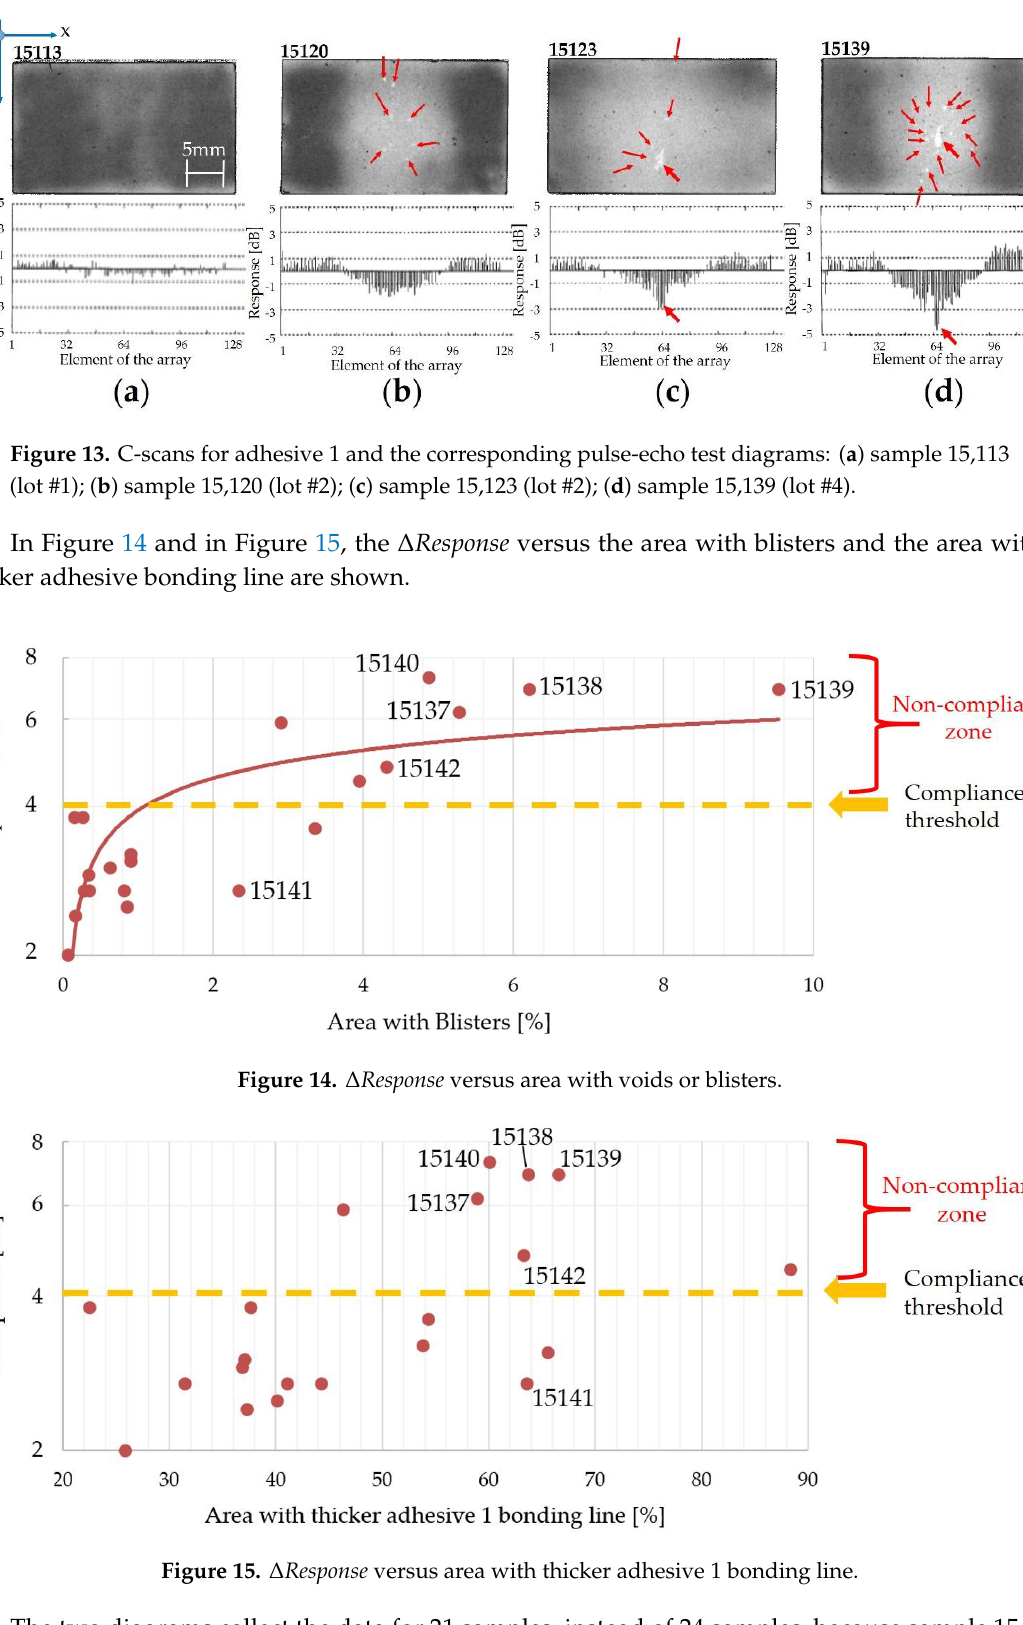
Figure 16. Detection of non-compliant areas [%] for lot #4: ( a ) blisters (blue color); ( b ) thicker epoxy resin (red color).